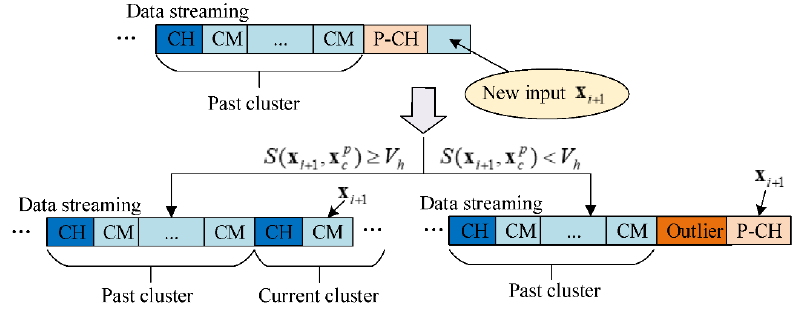
Figure 3. Data streaming clustering process for a new input.